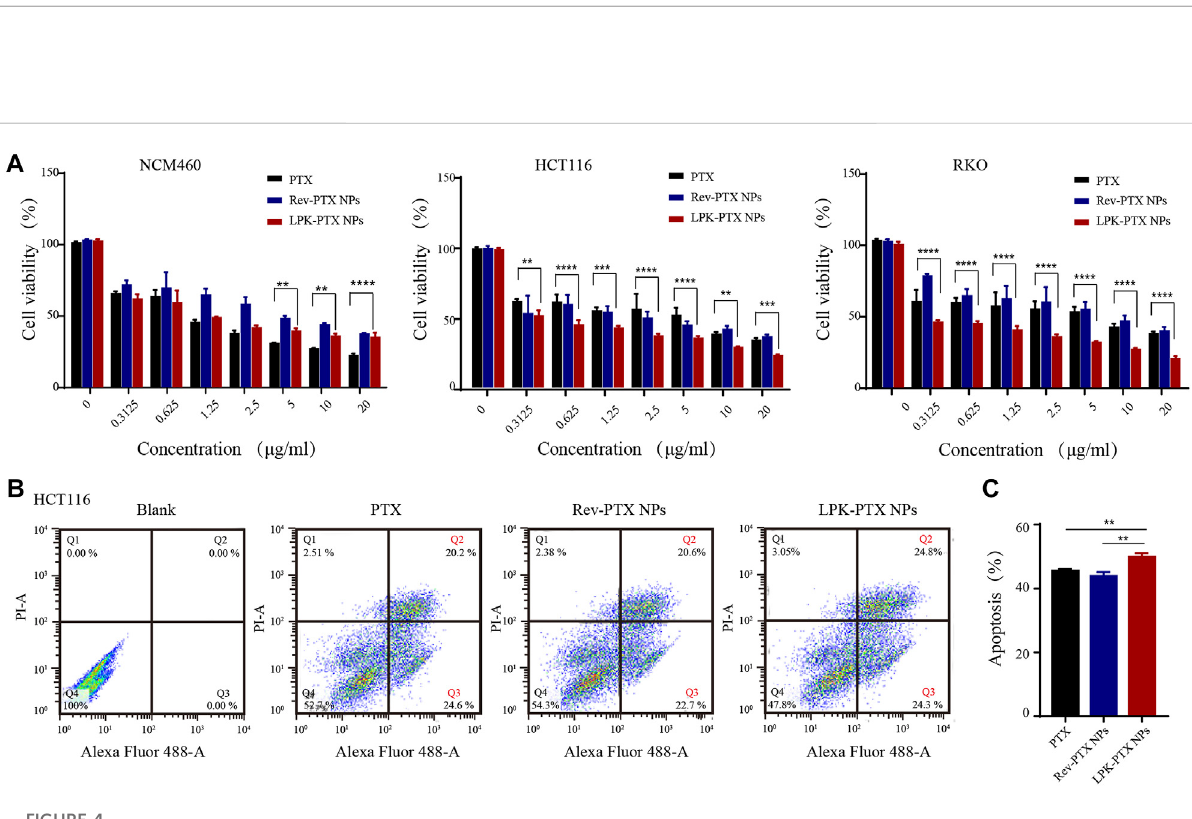
FIGURE 4 In vitro cytotoxicity of LPK-PTX NPs. (A) Cell viability of LPK-PTX NPs (PTX, Rev-PTX NPs as control groups) on normal cells NCM460 and colorectal cancer cells HCT116 and RKO after treated with various concentrations for 48 h. The concentration range of each compound was from 0.3125 μ g/ml to 20 μ g/ml. The data were presented as themeans± standard deviation. n = 5. * p < 0.05, ** p < 0.01, *** p < 0.001, **** p < 0.0001. (B) Cellular apoptosis of HCT116 cells treated with PTX, Rev-PTX NPs and LPK-PTX NPs were investigated by fl ow cytometry. A representative results of early apoptosis (Q3: PI -, Annexin V+) and late apoptosis (Q2: PI +, Annexin V +) induced by PTX, Rev-PTX NPs, and LPK-PTX NPs were 44.8% (20.2% + 24.6%), 43.3% (20.6% + 22.7%), and 49.1% (24.8% + 24.3%), respectively. (C) The percentage early and late apoptosis was analyzed. ( n = 3, ** p <